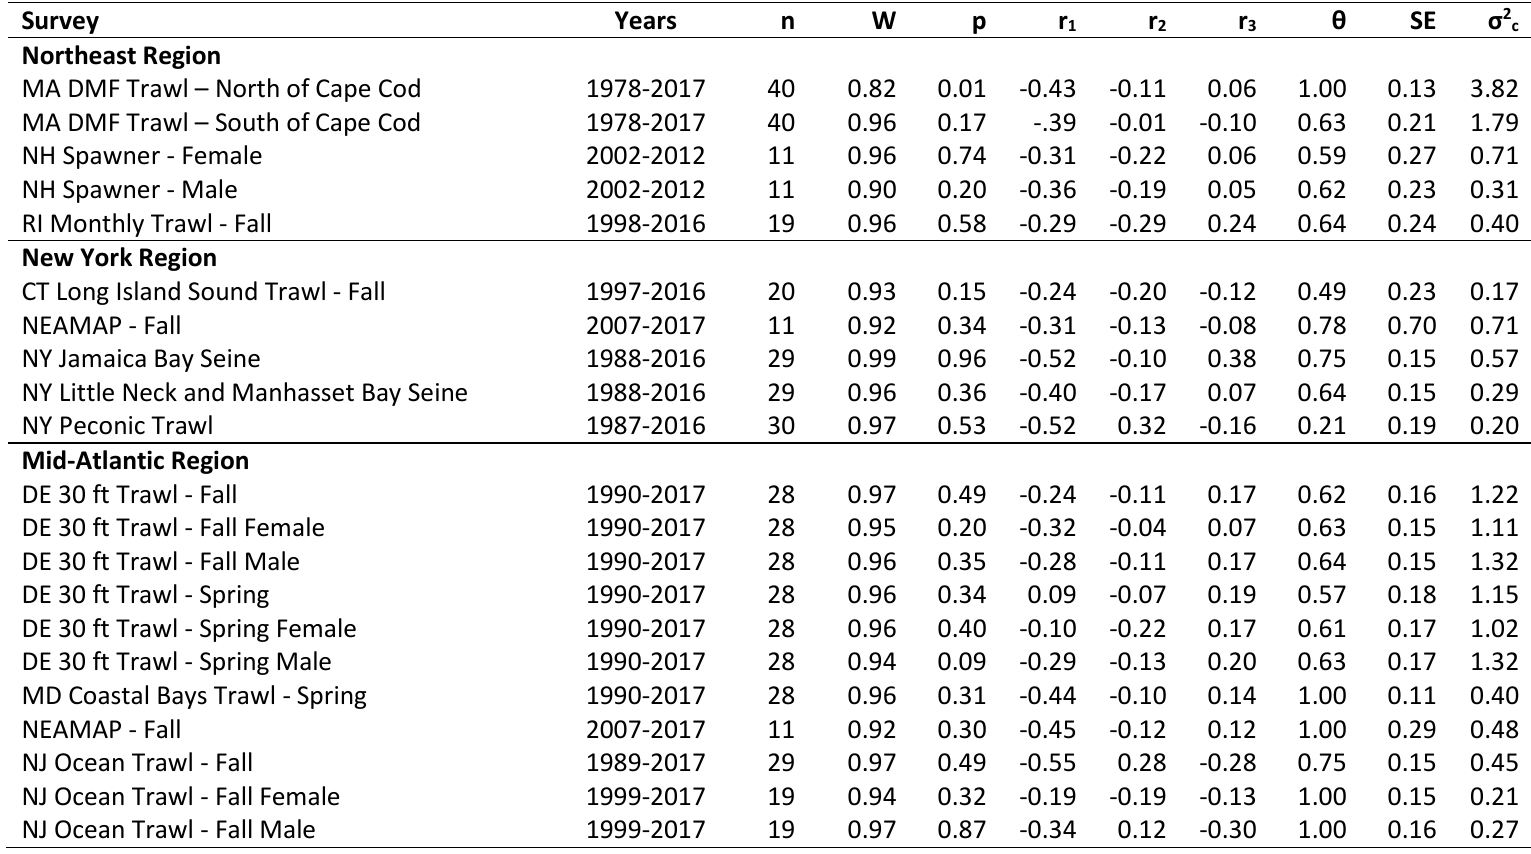
Table 38. Results of autoregressive integrated moving average (ARIMA) model fits for horseshoe crab surveys. W is the Shapiro-Wilk test statistic for normality of residuals (p value in parentheses); n is the number of years in the time series; r1, r2, and r3 are the first three autocorrelations; θ is the moving average parameter; SE is the standard error of θ; and σ 2 c is the variance of the